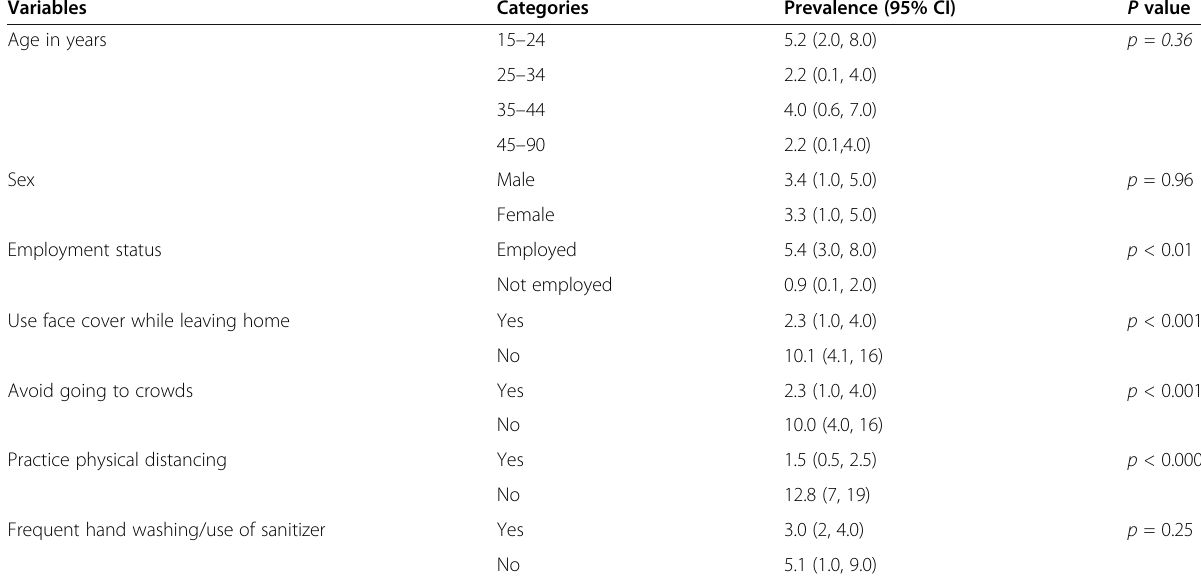
Table 3 Analysis of SARS-CoV-2 seroprevalence by selected factors among individuals aged above 15 years and residing in congregate settings of Dire Dawa city administration, Dire Dawa, Ethiopia, 2020 Variables